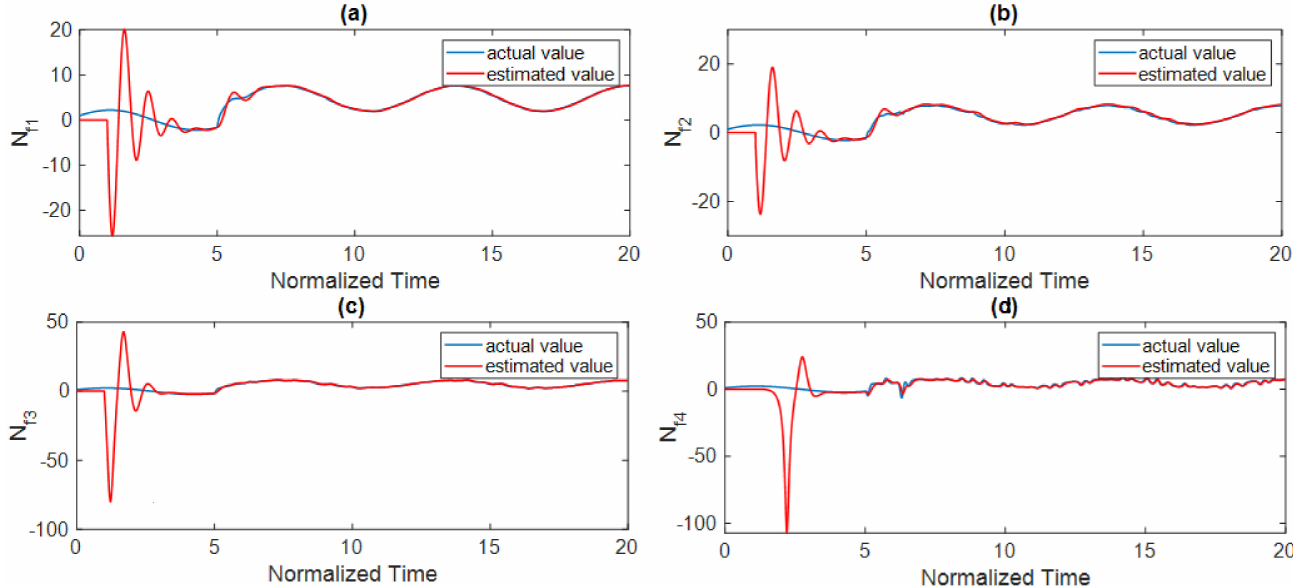
Figure 11. Estimated and actual value of faults and disturbances, where there are bias faults and partial loss of effectiveness. Disturbances and faults that are imposed on ( a ) x 1 , ( b ) x 2 , ( c ) x 3 , ( d ) x 4 .